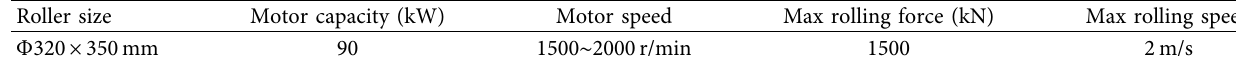
Figure 6: The specific process of hot rolling. Table 4: Performance parameters of the two-roll mill.